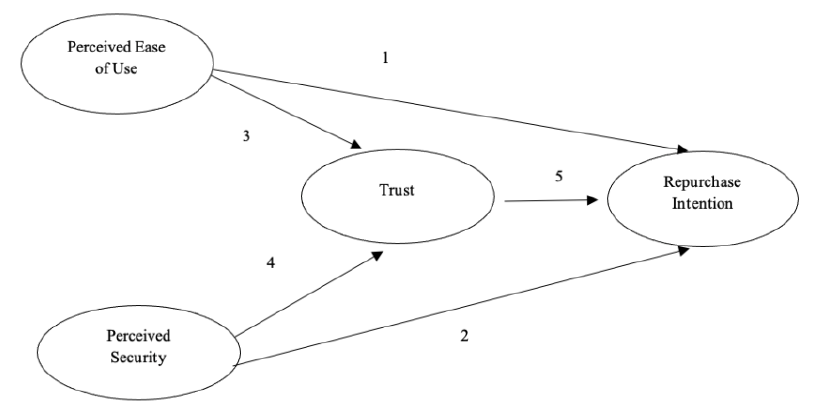
Figure 1: Conceptual Model of the Study; Source : Authors